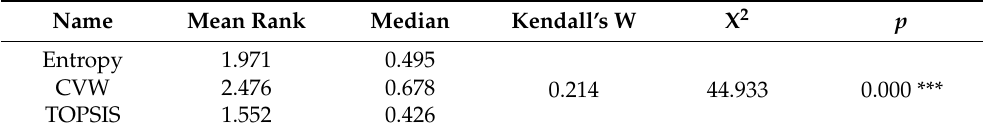
Table 3. The results of Kendall’s